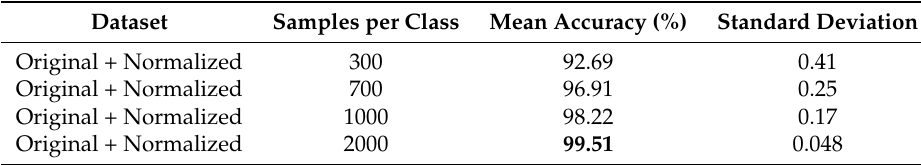
Table 7. Deep Learning experiments summary.